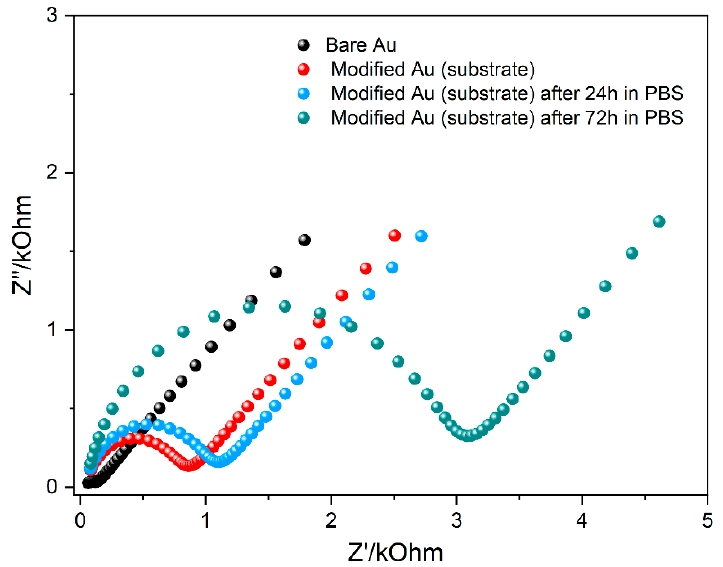
Figure 5. Nyquist plots of gold electrode (bare and modified) and their long-term storage in PBS buffer (pH = 7.4).